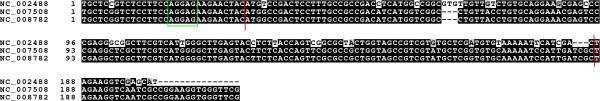
Missing gene group multiple alignment. A multiple alignment of missing gene Group 32. The green box shows the upstream RBS site "AGGAG". And the red lines mark the boundaries of the conserved ORF. The multiple alignment includes an additional 30 bp upstream and downstream of genomic DNA.